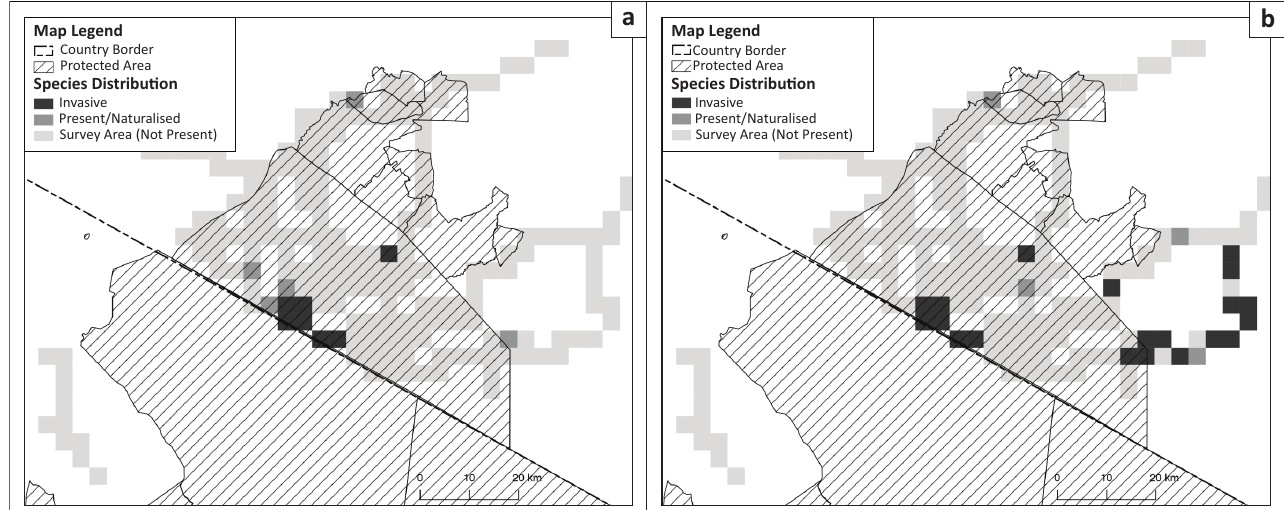
FIGURE 3: Successive surveys in (a) 2011 and (b) 2016 of Parthenium hysterophorus in the Masai-Mara National Reserve and surrounding areas in Kenya, showing the establishment of new populations to the east of the Reserve by